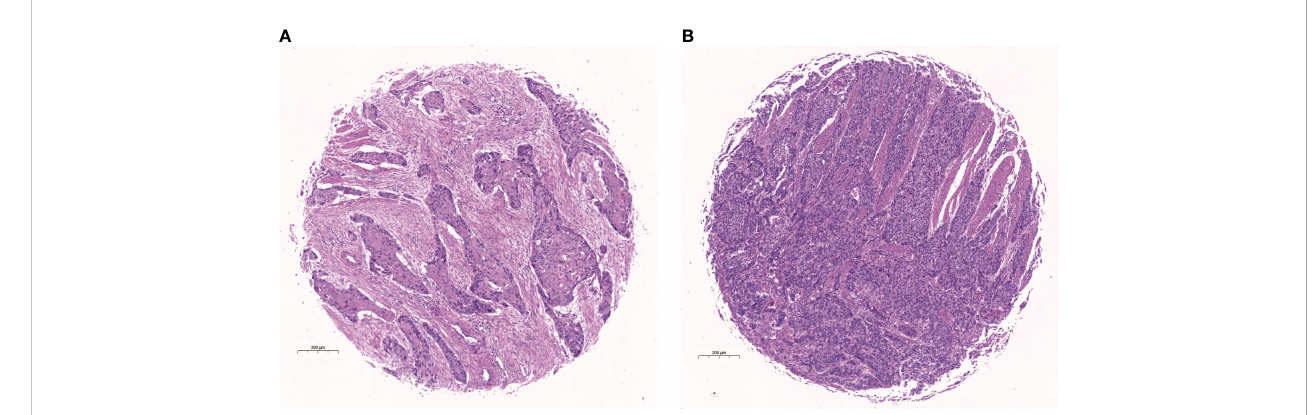
FIGURE 1 Hematoxylin-eosin (H&E) stained picture of the core of tissue microarray. (A) Example of stroma-rich group. (B) Example of stroma-poor